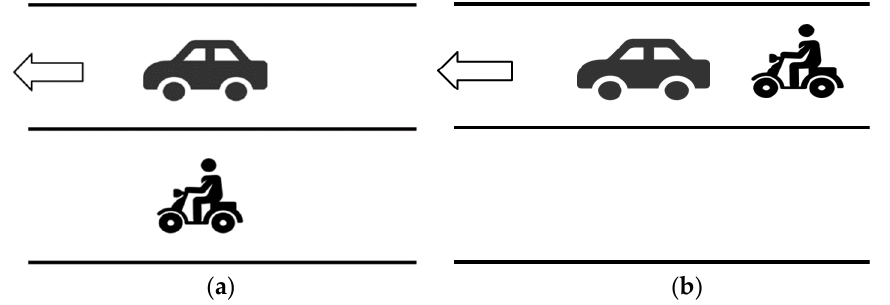
Figure 16. ( a ) Scenario 1: the vehicles are in parallel; ( b ) Scenario 2: the vehicles are in tandem. The average collected signal strengths were − 85.21, − 85.55, − 87.41 for RSSI using Blue- tooth sniffers, and − 22.03, − 31.86, − 36.1 for RSSI using Wi-Fi on rectangle, X-type, and di- amond-type topologies, respectively. The accuracy of the proposed solution for MDP is shown in Figure 17, where Figure 17a,b presents the experiment results of the collected signal data in Bluetooth and Wi-Fi, respectively. Experiment results of Scenario 1 (vehicles in parallel) and Scenario 2 (vehicles in tandem) show that the accuracy of estimating ve- hicle numbers was 100% except for the rectangle-type topology with Wi-Fi. It indicates that most of the mobile devices could be clustered into two groups (two vehicles) in spite of different scenarios, sensor topologies, and communication schemes.